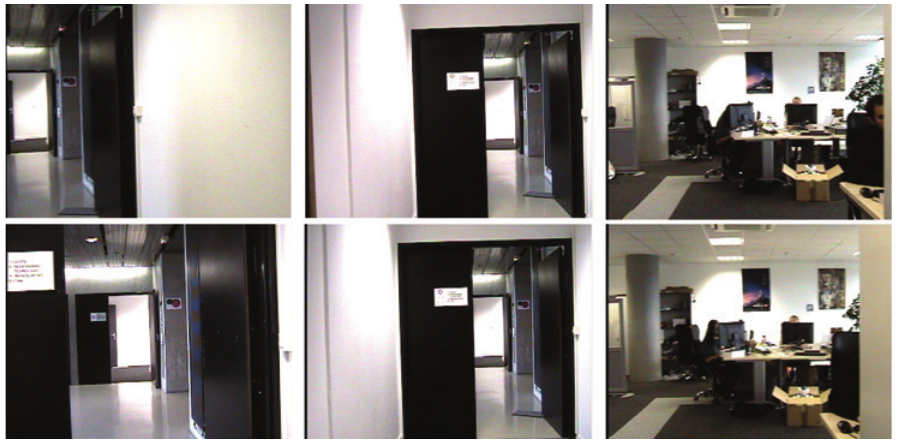
Figure 6. Examples of Loop-Closure Acceptance.